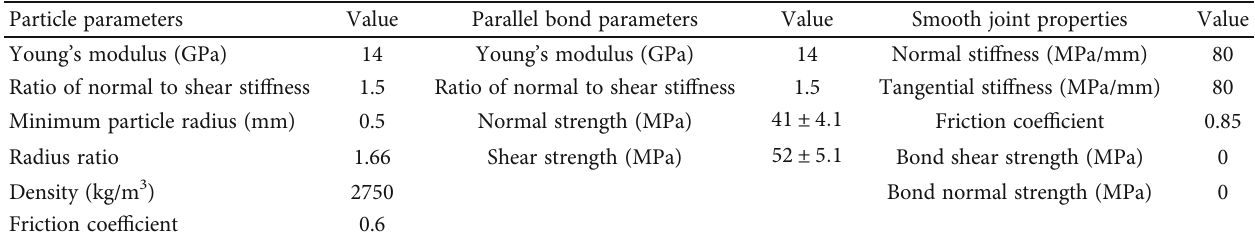
Table 3: Numerical calculation of microscopic mechanical parameters of high-strength rock